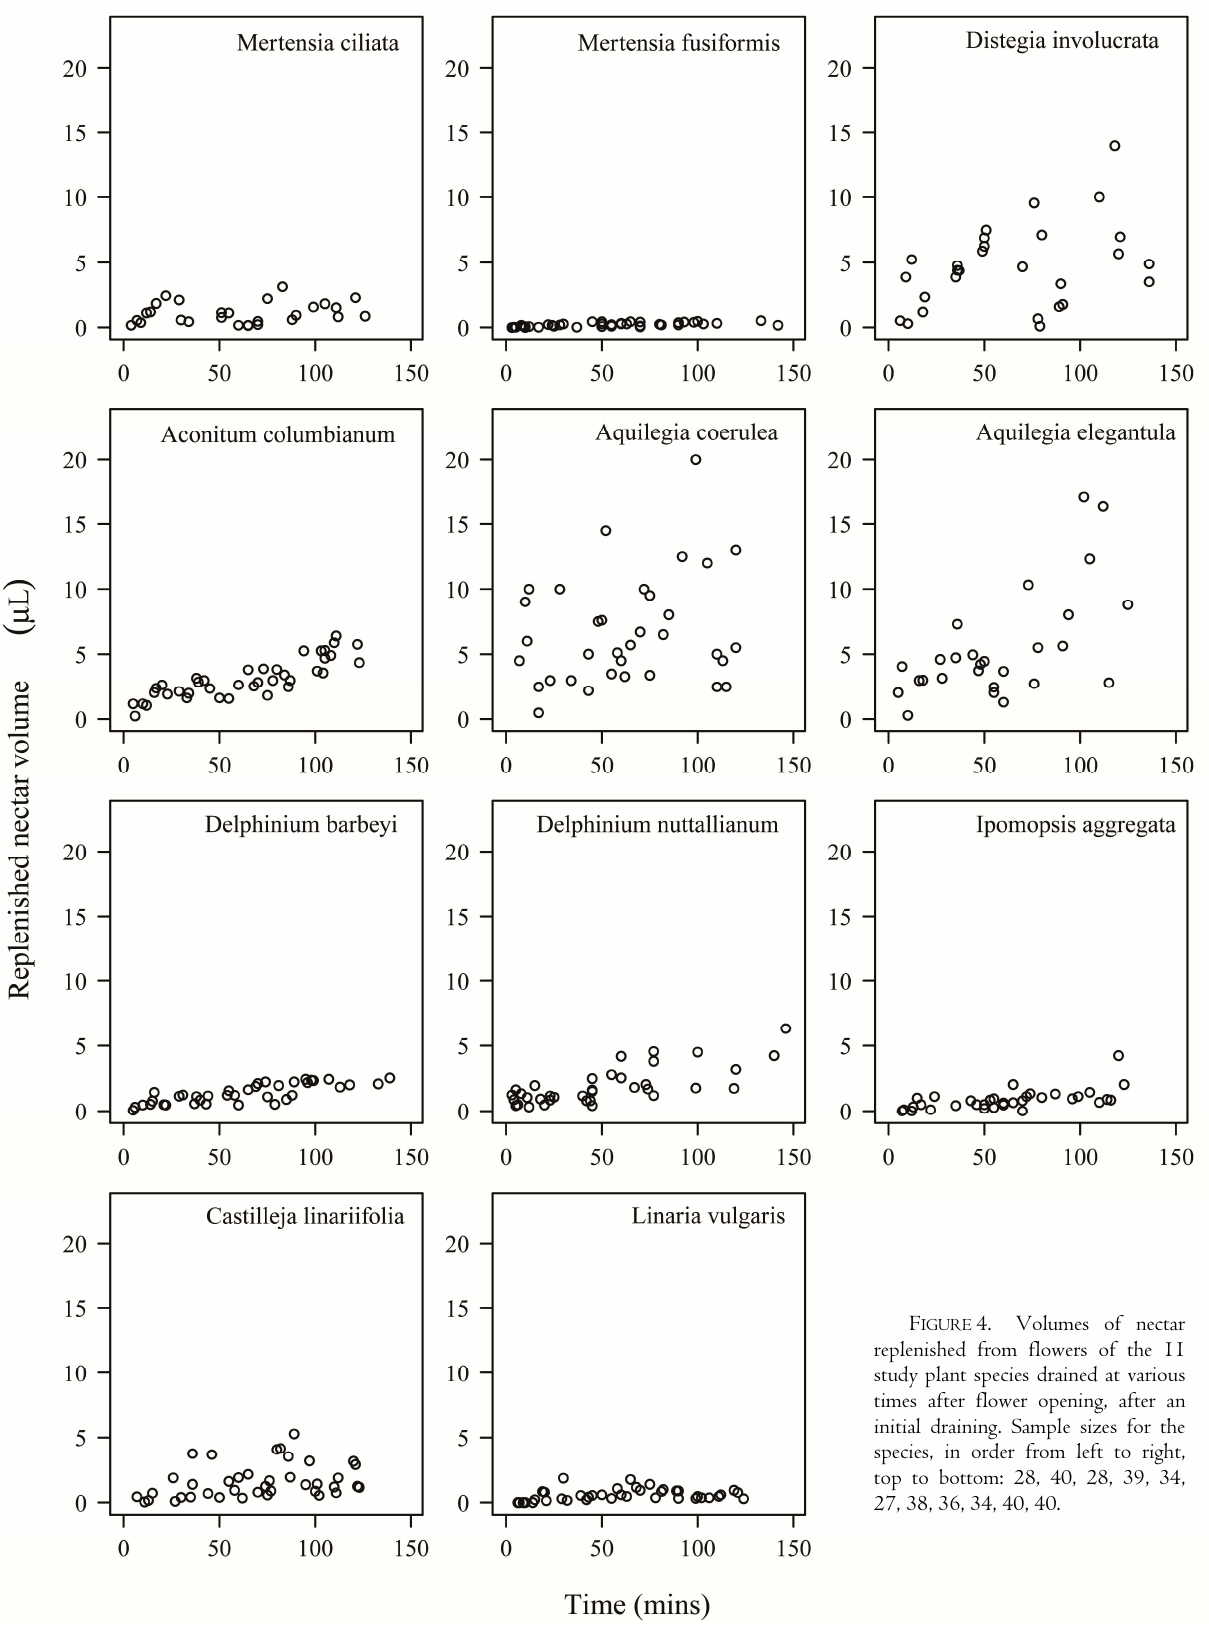
F IGURE 4. Volumes of